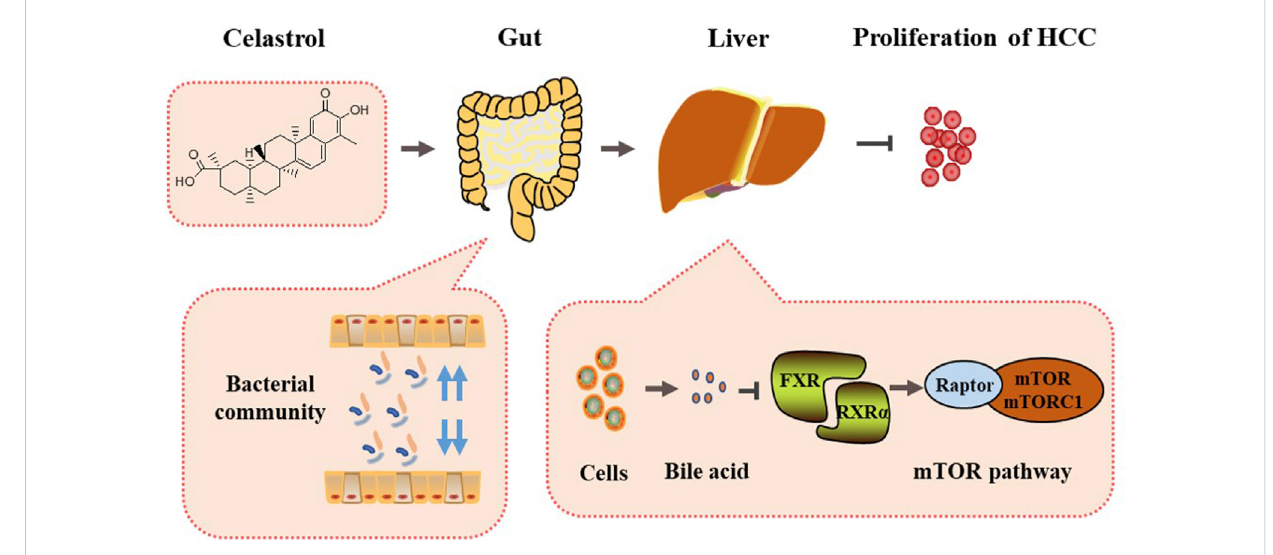
FIGURE 8 Mechanism summary of celastrol alleviating proliferation of hepatocellular carcinoma via regulation of the interaction of FXR with RXR α modulated by gut microbiota-associated bile acid